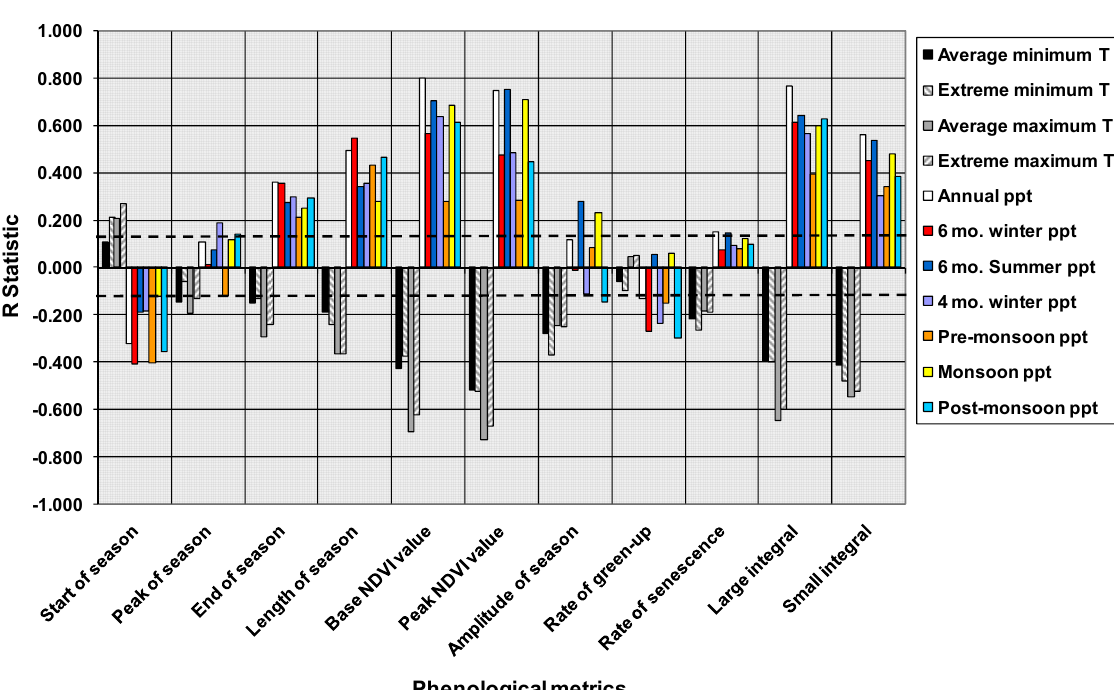
Figure 10. Correlations among phenometrics and temperature (T) and precipitations (ppt) metrics, across vegetation types, Santa Rita Mountains, AZ, USA, 2001–2006. The dashed lines represent the threshold of p = 0.05, corresponding to |R| ≥